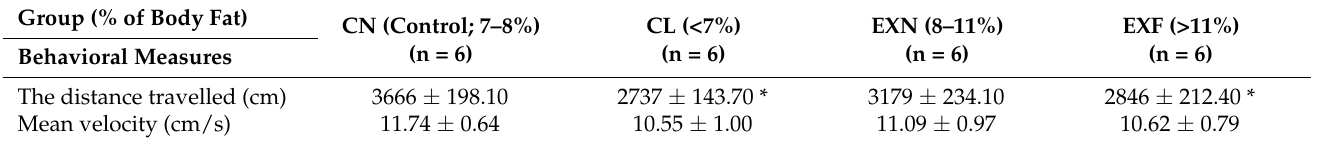
Figure 5. The total number of NADPH-d+ cells in the SZV/RMS neurogenic region in mice with various body conditions. Abbreviations: SVZ—subventricular zone; RMS—rostral migratory stream; (CN) control group of mice characterized by normal weight and physiological percentage of body fat deposits; (CL) control group of mice characterized by reduced weight and reduced body fat deposits; (EXN) experimental group of mice characterized by normal weight and moderately elevated body fat deposits; (EXF) experimental group of mice characterized by markedly elevated weight and body fat deposits. Data are shown as mean ± SEM. Statistical significance of differences between experimental and control groups: * p ≤ 0.05, *** p ≤ 0.001. Table 5. Behavioral scores for locomotor activity in open field test in mice with various body conditions. Data are shown as mean ± SEM. Abbreviations: (CN) control group of mice characterized by normal weight and physiological percentage of body fat deposits; (CL) control group of mice characterized by reduced weight and reduced body fat deposits; (EXN) experimental group of mice characterized by normal weight and moderately elevated body fat deposits; (EXF) experimental group of mice characterized by markedly elevated weight and body fat deposits. Statistical significance of differences between experimental and control groups: * p ≤ 0.05.